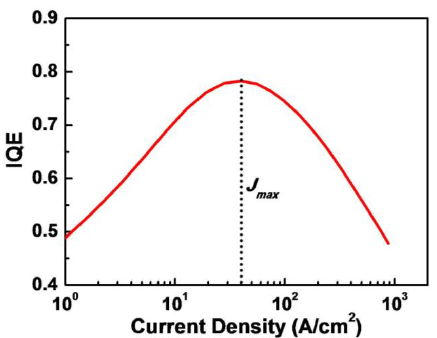
Figure 3. The calculated relationship between IQE and injection current density of GaN-based LDs before lasing.